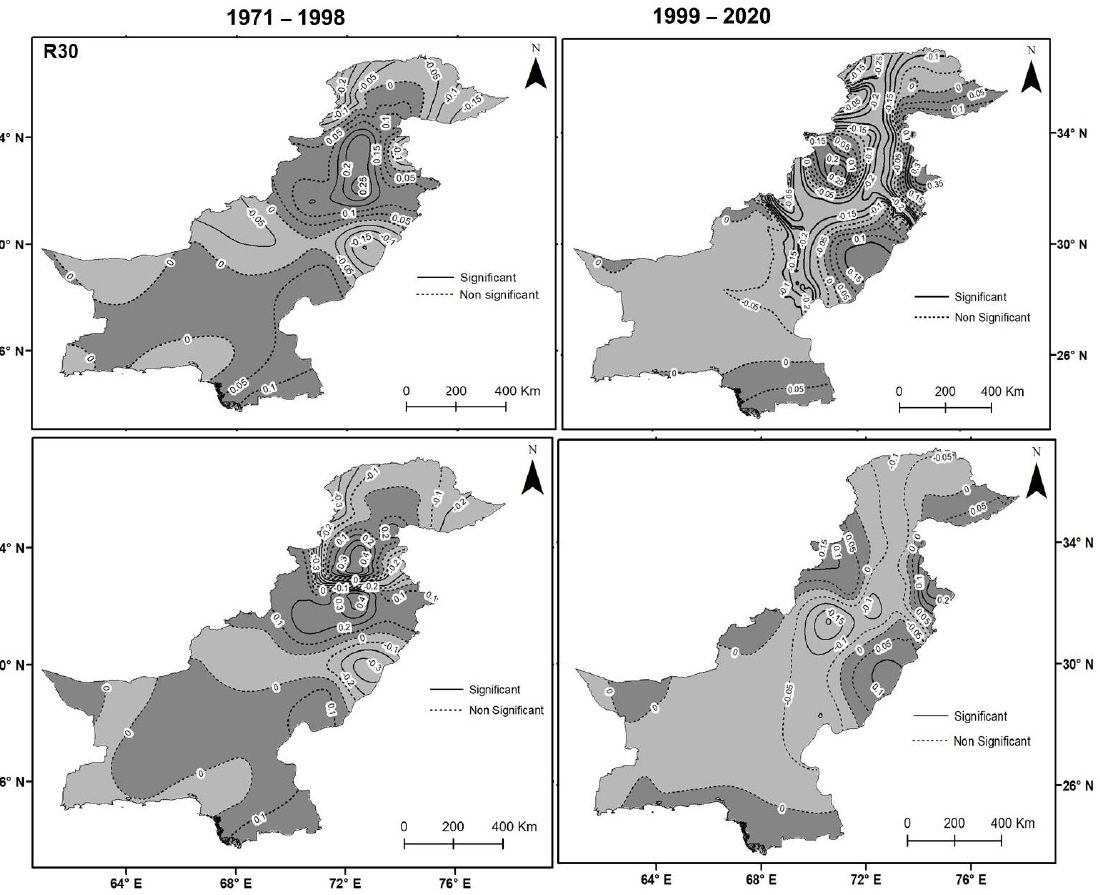
Figure 6. Spatial trends for extreme precipitation indices R30 and R50 (days)between 1971 and 1998 as well as 1999 and 2020. Dark color indicates the positive changes and light color shows the negative changes at 0.05 level of significance.